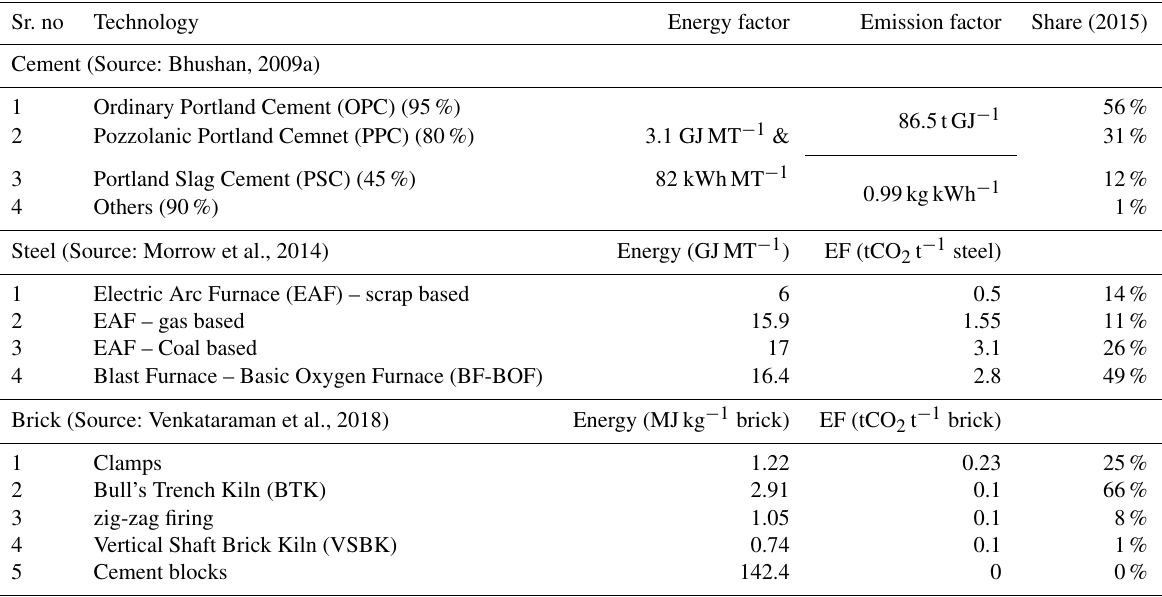
Table 1. Production technologies for cement, steel and brick manufacturing with their share (percentage) in India in 2015, energy factors (GJMT − 1 ) and emission factors (tCO 2 t − 1 ). Sr.